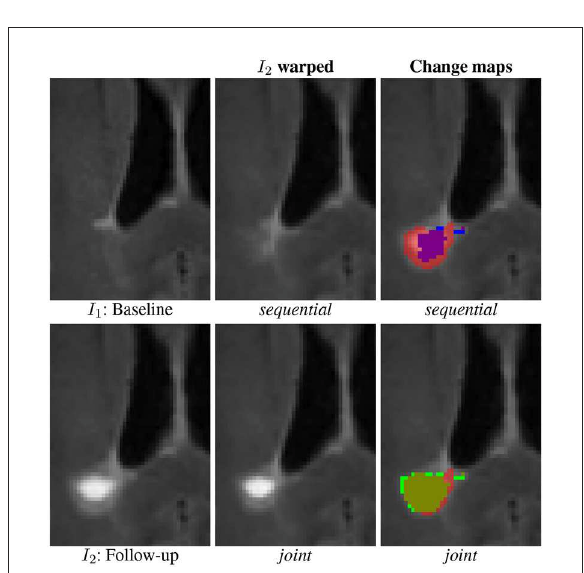
FIGURE8 Qualitative comparison of the binary change detection maps obtained with the sequential (purple) and joint (green) approaches as compared to the ground truth (underlying transparent red) on one selected subject from the MSSEG-2